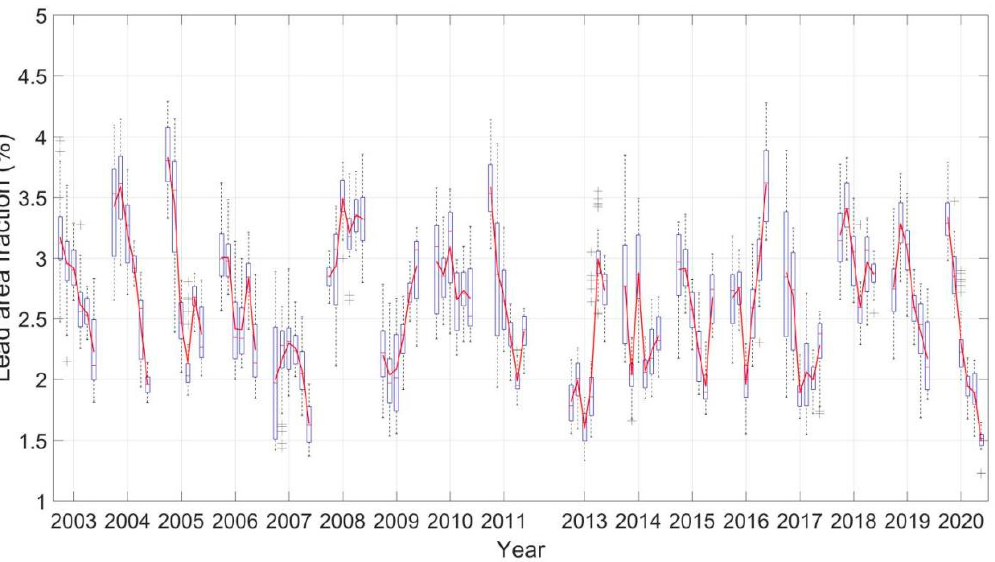
Figure 4. Evolution of sea ice lead fraction in the Arctic north of 65°N in the AMSR family data. On each blue box the central mark indicates the median, and the bottom and top edges of the box indicate the 25th and 75th percentiles, respectively. The whiskers extend to the most extreme data points and the outliers are plotted using the ‘+’ marker symbol. The red lines denote monthly means.